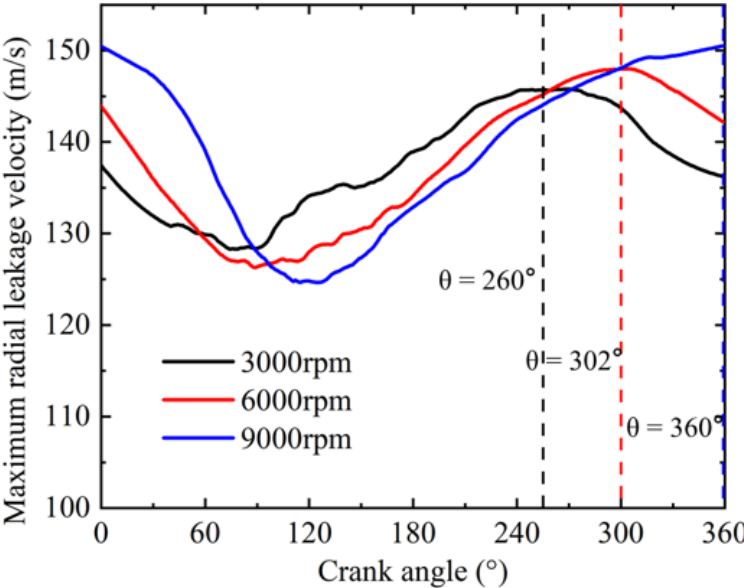
Figure 16. Variations in the maximum radial leakage velocity with the crank angle.